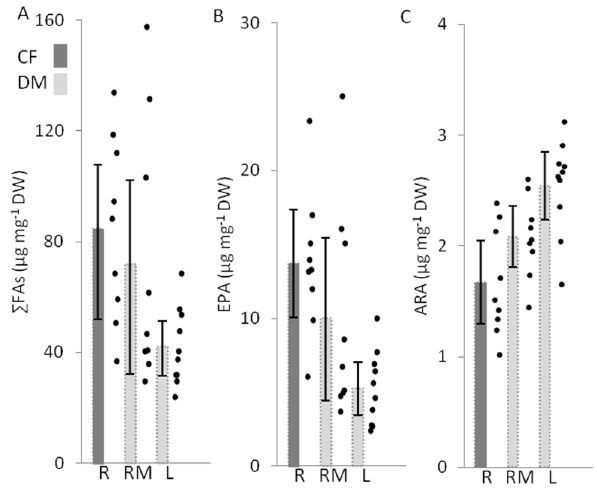
Figure 4. Total fatty acid ( g FA), EPA and ARA in river (R) caddisflies, and dreissenid mussels collected in rivermouths (RM) and the nearshore of Lake Michigan (L). Raw data (points) and averages (with 95% credible intervals) are shown here. Although not presented, the trends in g FA in seston largely mirror trends in PUFAs, MUFAs, DHA, ALA and LIN (see Table S3 and Appendix S2). Statistical significance is inferred by the lack of overlap between credible intervals (no statistically significant differences occur here). To highlight differences in taxa, the bar representing caddisflies has been shaded